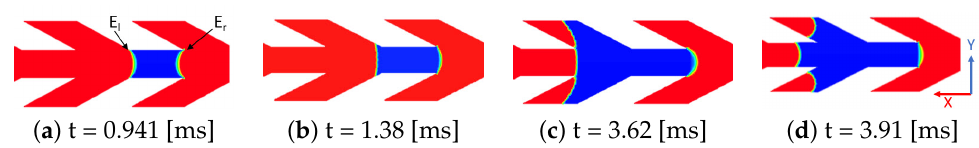
Figure 10. Snapshots of the asymmetric transport using the 2D VOF simulation. Parameters as in Figure 9.